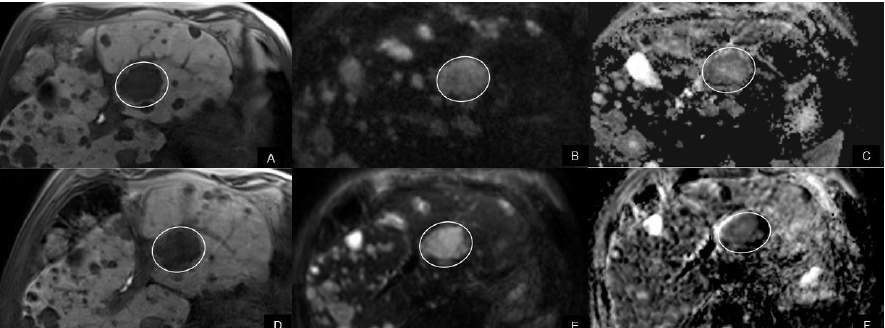
Figure 3. A 66-year-old male with liver metastases of pNET classified as a responder. ( A ) The pre-interventional axial T1w image (hepatobiliary phase) shows hypointense metastasis (circle) in segment 2. The metastasis (arrow) shows restricted diffusion with high signal on axial DW-MR image b = 800 s/mm 2 ( B , D ) dark signal (circle) on ADC map ( C ). The pretherapeutic ADCmin value of the metastasis was 858 × 10 − 3 mm 2 /s. Under everolimus, the metastasis showed no significant change in size on hepatobiliary phase ( D ), however there was a loss of signal on DW-MR image b = 800 s/mm 2 ( E ) compared to the pre-interventional image and decreasing signal (circle) on the ADC map ( F ). The post-interventional ADCmin values were 476 × 10 − 3 mm 2 /s and lower higher compared to pretherapeutic ADC